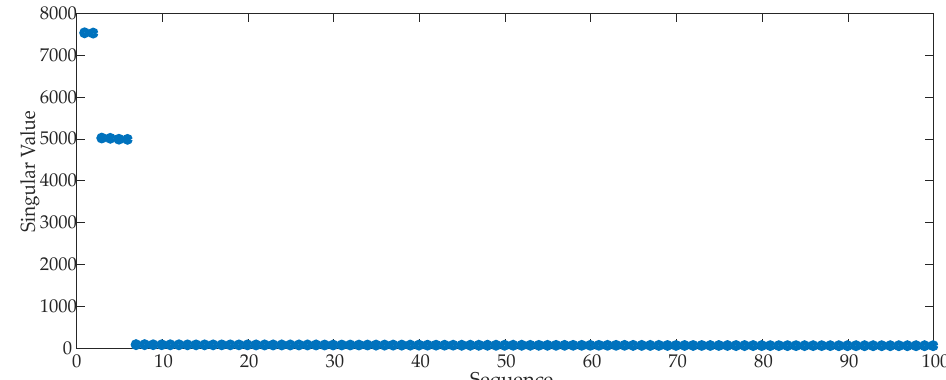
Figure 7. Singular value distribution of PD signal superimposed with white noise and periodic narrowband interference signals.